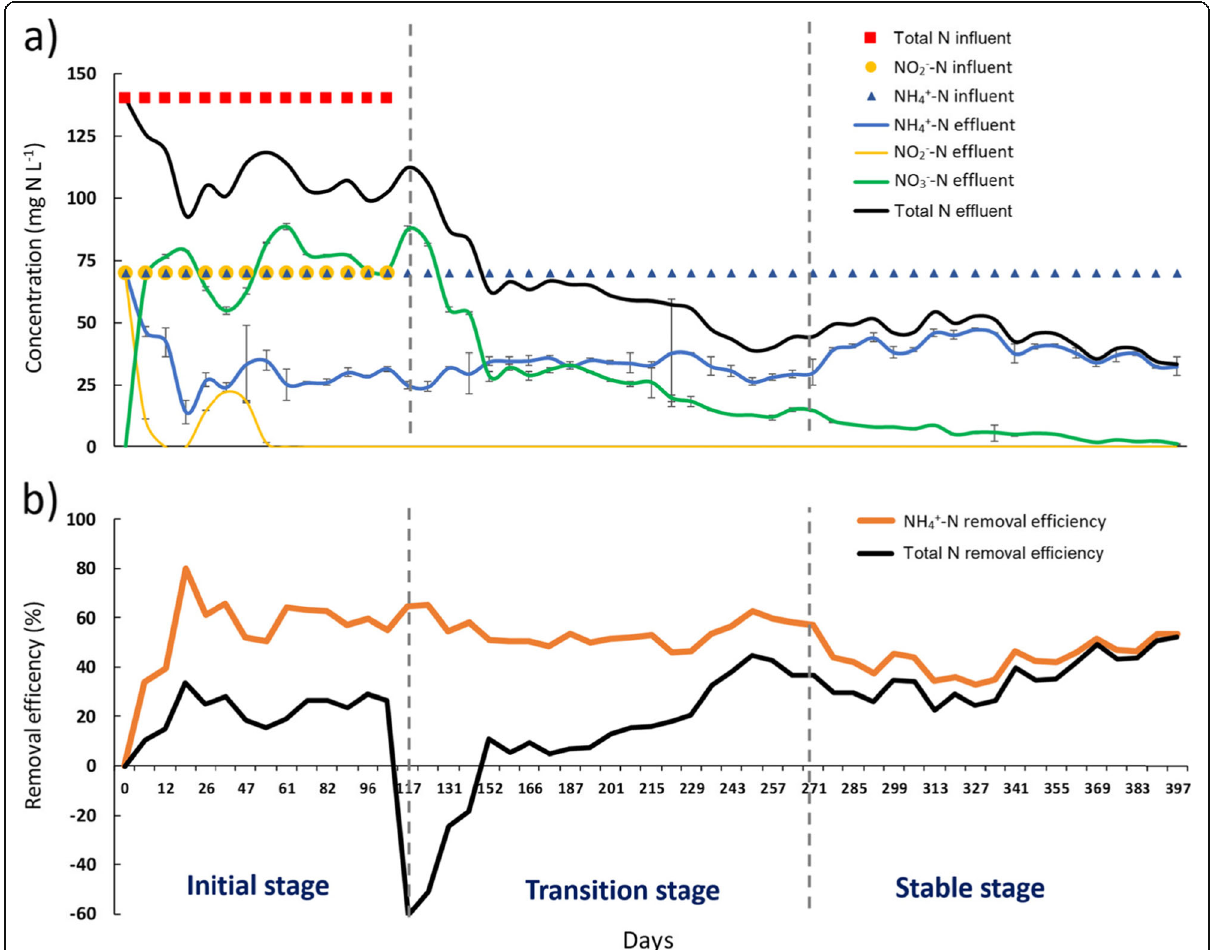
Fig. 2 Reactor performance during the different stages of the start-up, a) Profiles of nitrogen (N) in the form of ammonium (NH 4+ -N), nitrite (NO 2- -N) in the influent, and NH 4+ -N, NO 2- -N, nitrate (NO 3- -N), and the sum of N forms (Total N) in the effluent. b) Profile of the removal efficiency of N in the form of ammonia, and total